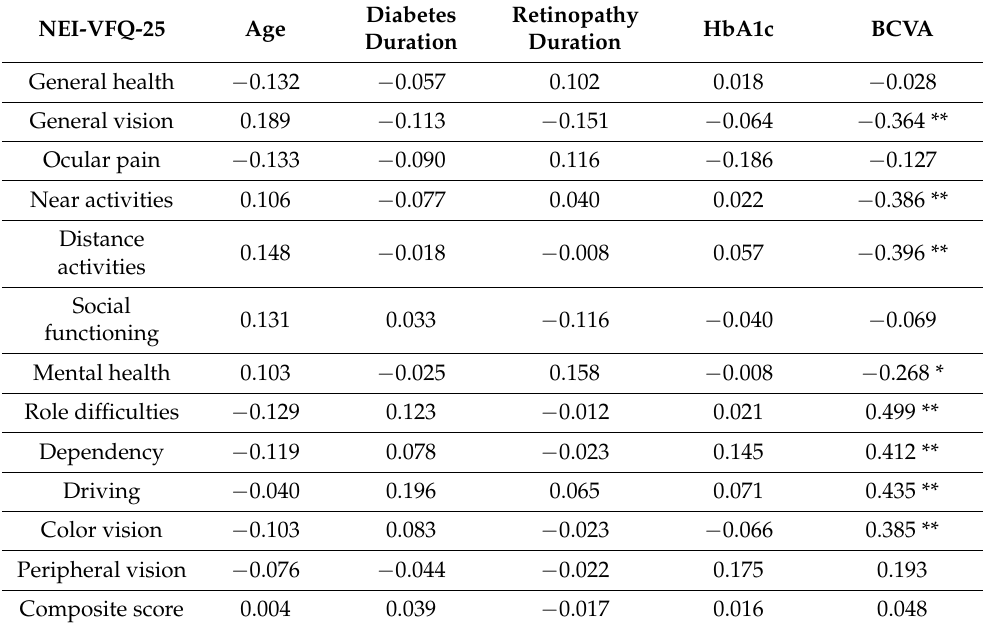
Table 3. Correlation between the subscales and the total score of the NEI-VFQ-25 and continuous